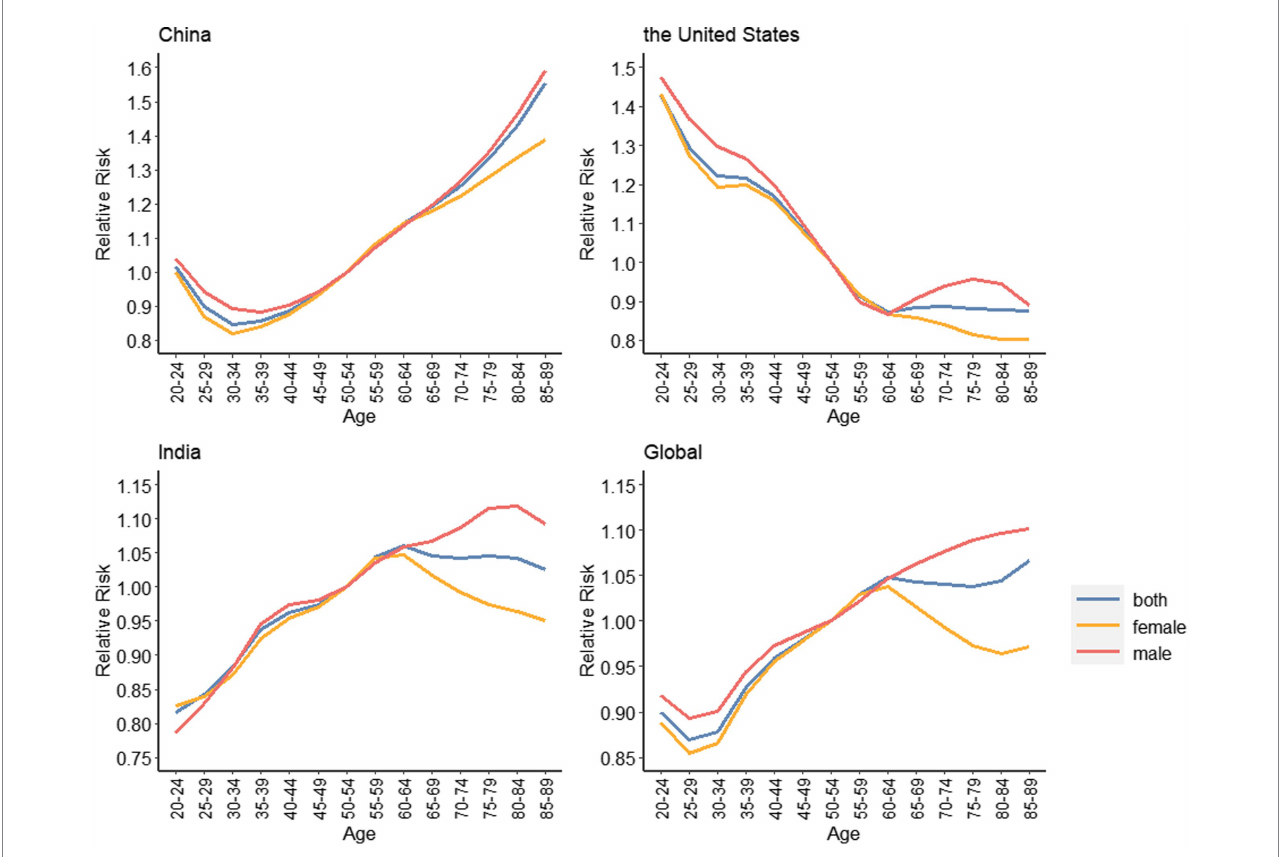
FIGURE 5 Age effects on depressive disorders incidence rate for China, the United States, India and the global,